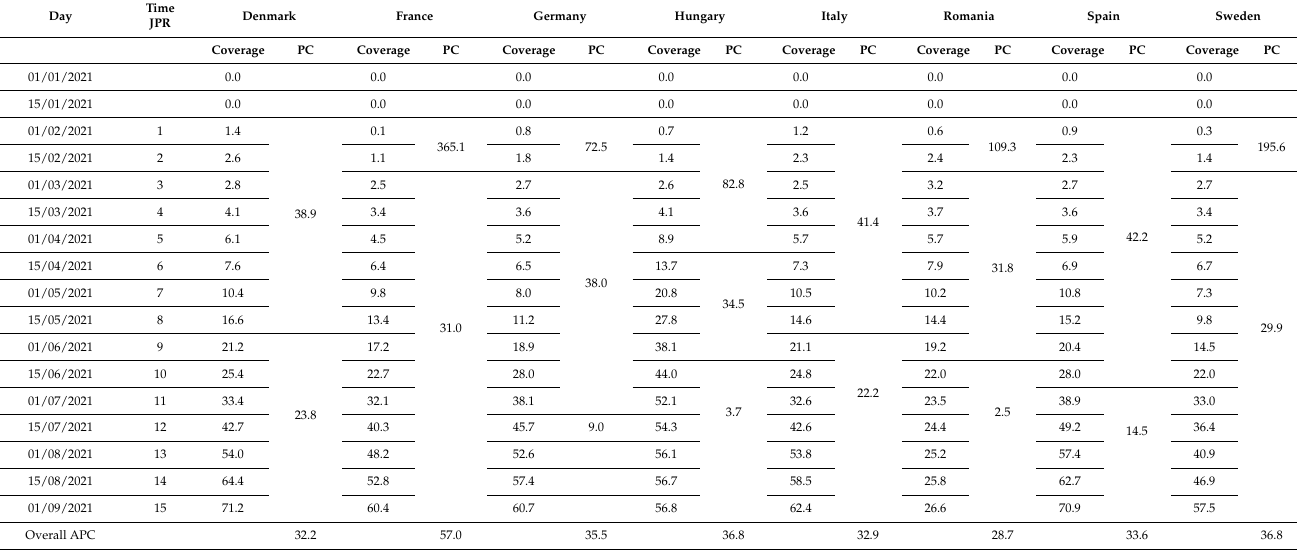
Table 1. Full vaccination coverage by considered time points, percentage change (PC) and average percentage change (APC). January–August